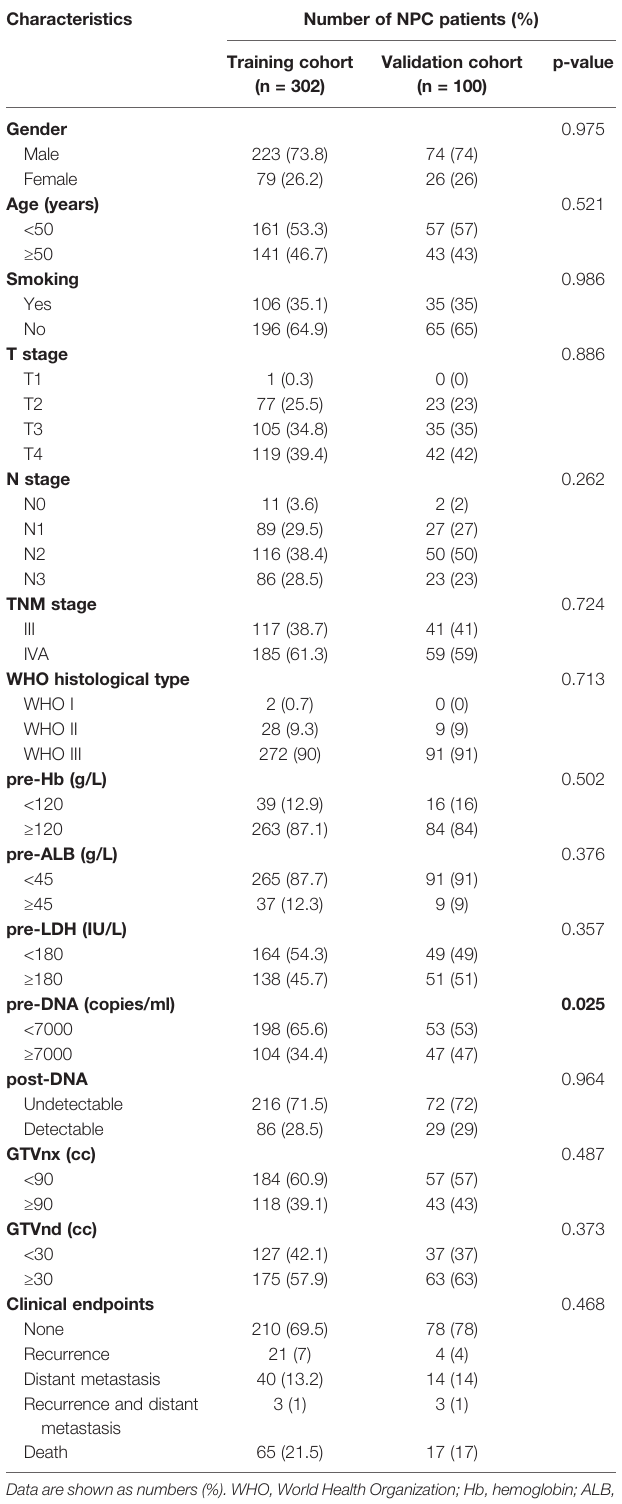
TABLE 1 | Baseline characteristics of the patients. (n=